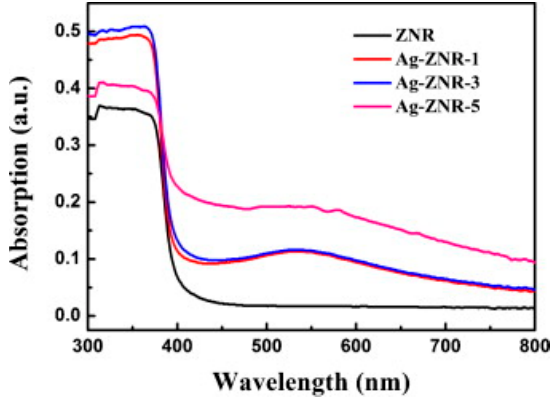
Figure 72. Normalized extinction spectra of ( a ) spherical Ag, Au, and Cu; ( b ) Ag nanoparticles with different nanostructure: wires, spheres, cubes; ( c ) Ag nanocubes as a function of size. The inset in ( c ) is an image of the Ag nanocubes of different sizes suspended in ethanol respectively. Reproduced with permission from [122].